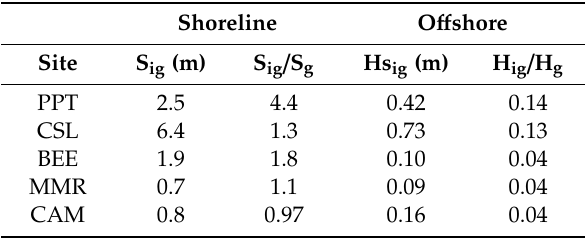
Table 6. Representative infragravity heights and dominance, at the shoreline and o ff shore, during the times of high incident wave energy, as presented in Figure